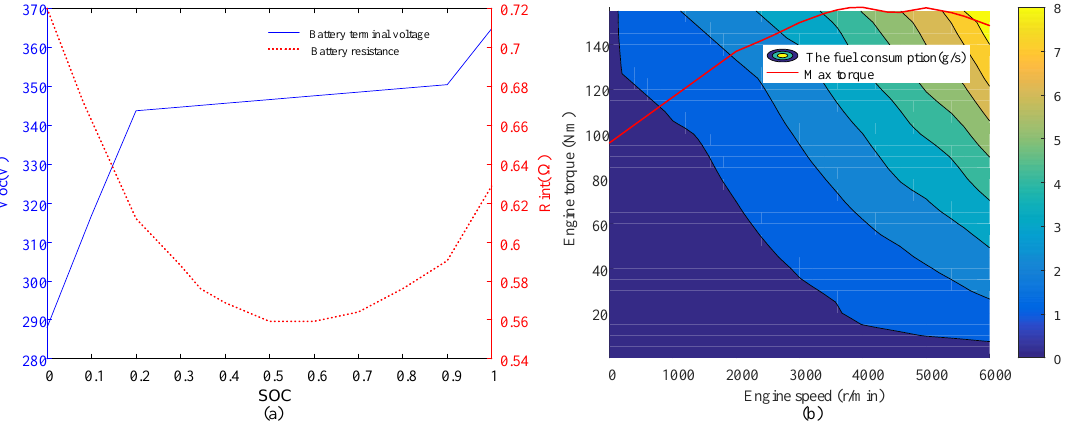
Figure 4. Operating mode switching strategy.